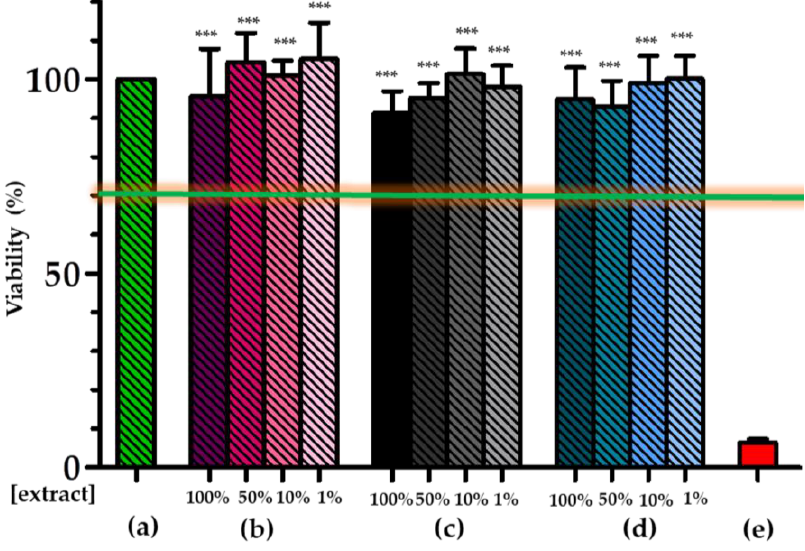
Figure 2. Viability of cells exposed to IPN extraction vehicles. An 3-(4,5-dimethylthiazol-2-yl)-5-(3-carboxymethoxyphenyl)-2-(4-sulfophenyl)-2H-tetrazolium, inner salt (MTS) cytotoxic assay was performed on cells cultured with IPN extraction vehicles from the three investigated materials and controls: non-treated cells (negative cytotoxic control) ( a ), HSAm(10%)fb(0.5%) IPNs ( b ), PEO(5%)coHSAm(5%)fb(0.5%) IPNs ( c ), PEO(10%)fb(0.5%) ( d ) IPNs and latex group (positive cytotoxic control) ( e ). Various extract concentrations were screened for IPN materials varying from 1%–100%. Values represent the mean and SD ( n = 5). Differences between groups were statistically significant. Data were normalized with respect to the non-treated controls ( a ) and analyzed using one-way ANOVA, *** p ≤ 0.0001.